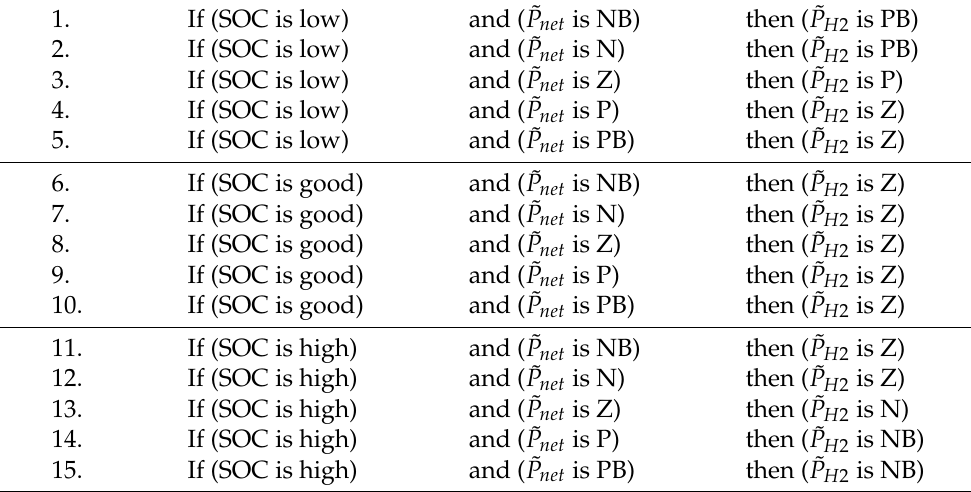
Table 1. Fuzzy logic controller rule